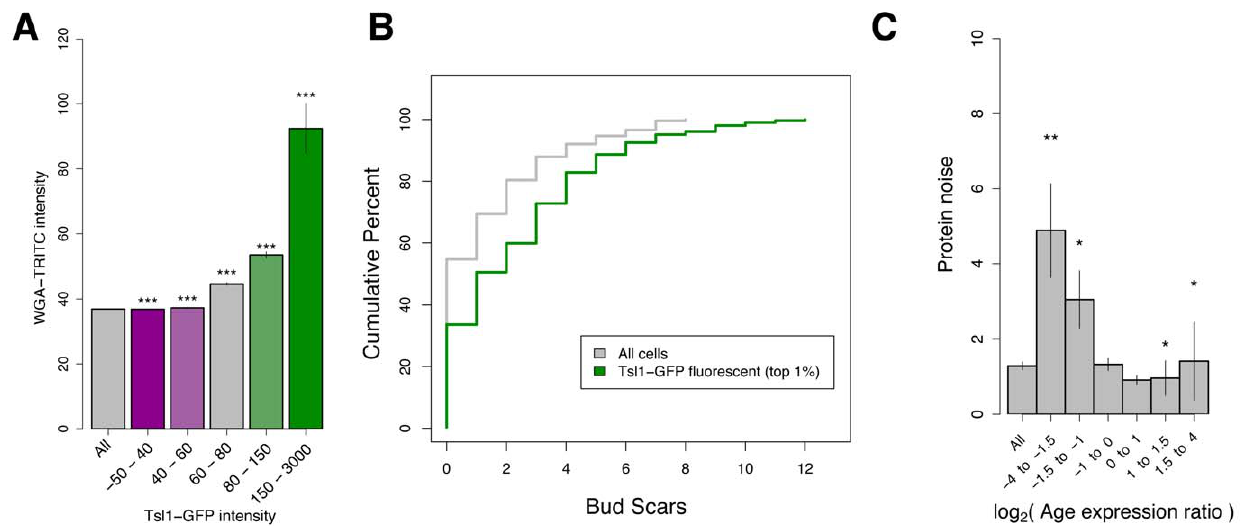
Figure 5. Old cells are Tsl1-GFP abundant. (A) TSL1 -GFP yeast stained with the bud scar stain WGA-TRITC are passed though a cell sorter to monitor co-fluorescence. Shown is the WGA-TRITC fluorescence of cells binned by Tsl1-GFP fluorescence. p -Values are a comparison to all cells, Wilcoxon-Mann-Whitney test: ***, p , 1 6 10 2 10 . (B) Sorted WGA-TRITC stained TSL1 -GFP cells are counted for bud scars. Shown is the cumulative percentage of all cells (grey) and cells in the top 1% Tsl1-GFP fluorescence bin (green). The 1% Tsl1-GFP cells have significantly more bud scars, Wilcoxon-Mann-Whitney test, p , 1 6 10 2 7 . (C) Population demography accounts for some expression ‘‘noise.’’ Shown is the protein-expression noise (DM in yeast permissive dextrose media from [4]) of genes binned by logarithm of their age expression ratio, the average expression in young